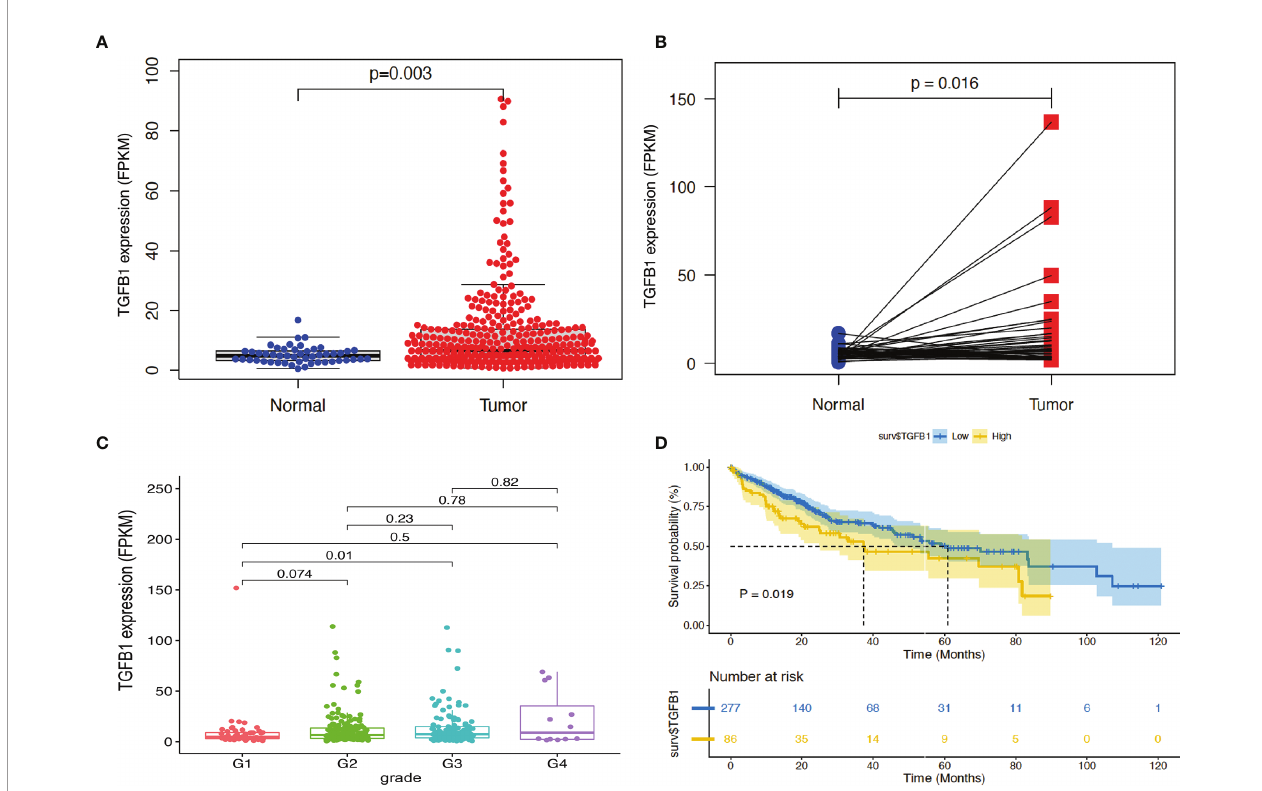
FIGURE 4 | Bioinformatic analysis revealed high TGF- b 1 expression in HCC tissues, with poor survival time. RNA-seq data (FPKM) of 374 HCC tissues and 50 non-HCC liver tissues were extracted from TCGA database (portal.gdc.cancer.gov). TGF- b 1 expression and p -value were computed using limma and beeswarm packages for the 374 samples (A) and the 50 pairs of HCC tissues with the corresponding neighboring non-tumorous liver tissues (B) . (C) Correlation analysis of TGF- b 1 expression in HCC tissues of different grades using ggpubr and tidyverse packages. G1: N = 55; G2: N = 179; G3: N = 124; G4: N = 12. (D) Kaplan – Meier survival curve analysis of TGF- b 1 expression level and survival time using the survival package. p < 0.05 and p < 0.01 suggest signi fi cance and strong signi fi cance,